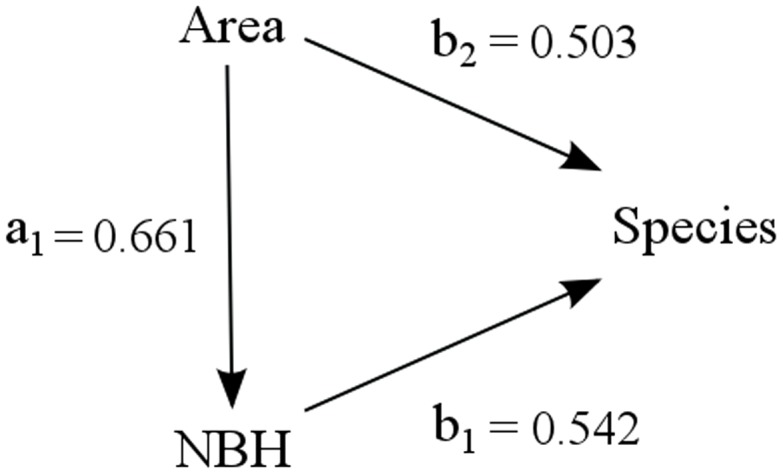
Path model of species number as a function of area and number of breeding habitats.Arrows indicate the direct effect of one variable on another. Number of suitable breeding habitats (NBH). Path coefficients represent: (a1) direct effect of area on NBH; (b1) direct effect of NBH on species number; and (b2) direct effect of area on species number.